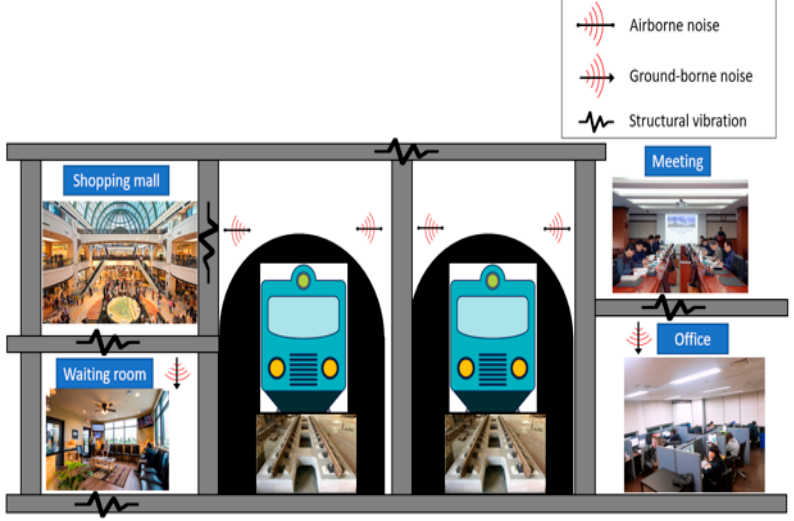
Figure 1. The structural vibration transfer path.